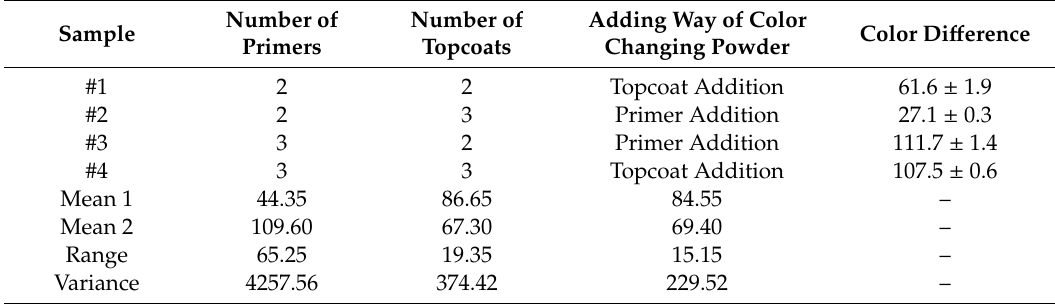
Table 4. Results of the orthogonal experiment of the influence of coating technology on the color di ff erence of paint film.